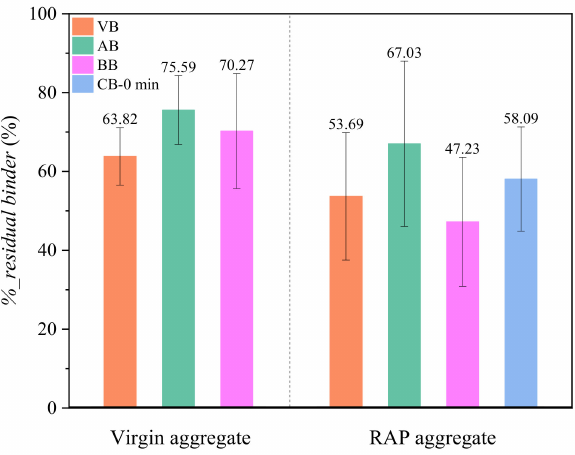
Figure 14. Results from the modified boiling